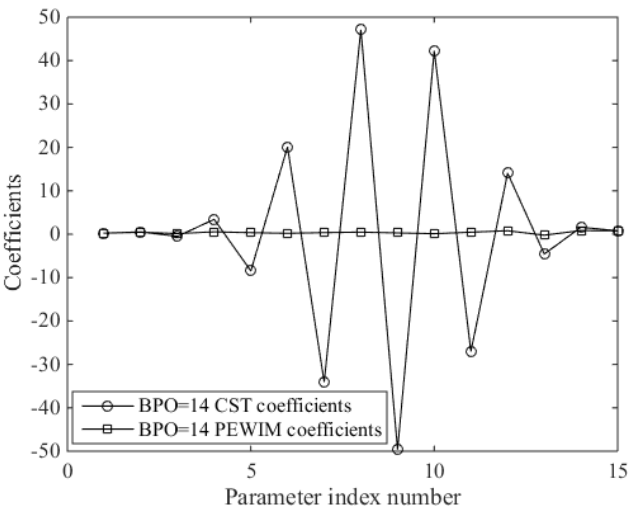
Figure 11. Comparison between the CST method and the PEWI method of the upper airfoil.